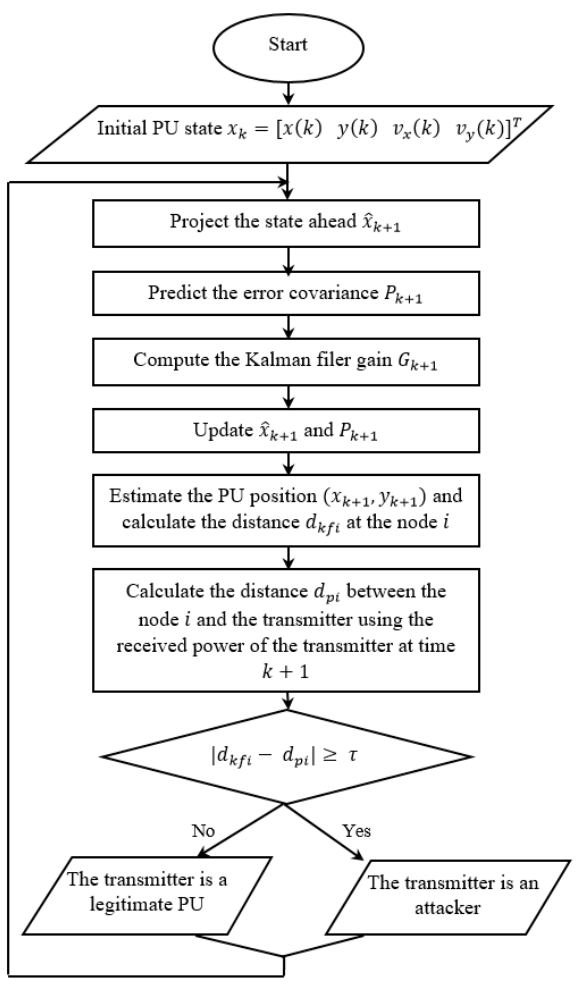
Figure 1. Flowchart of the proposed approach.